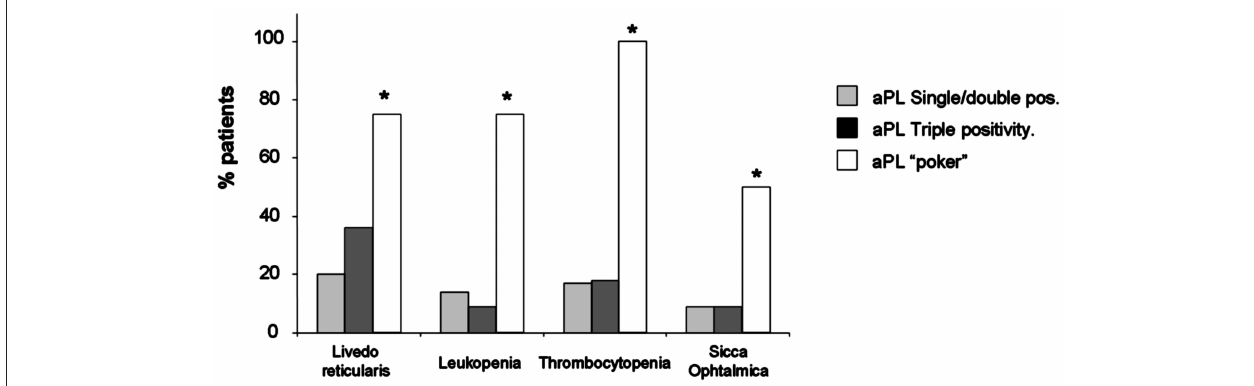
FIGURE 3 | Prevalence of aPL simple/double positivity (gray bar), triple aPL positivity (dark bar), and quadruple aPL positivity or poker aPL positivity (white bar) in patients with livedo reticularis, ophthalmic sicca, leukopenia and thrombocytopenia. * p < 0.05 respect simple/double positivity.